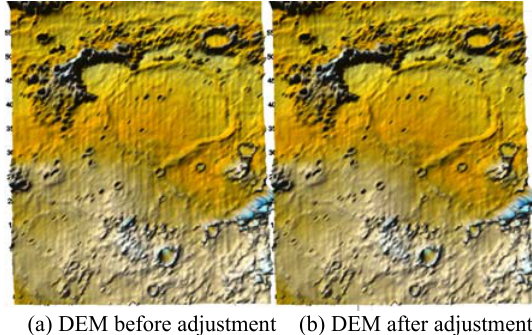
Figure 4. DEMs before and after a 2-order polynomial adju- stment of crossovers